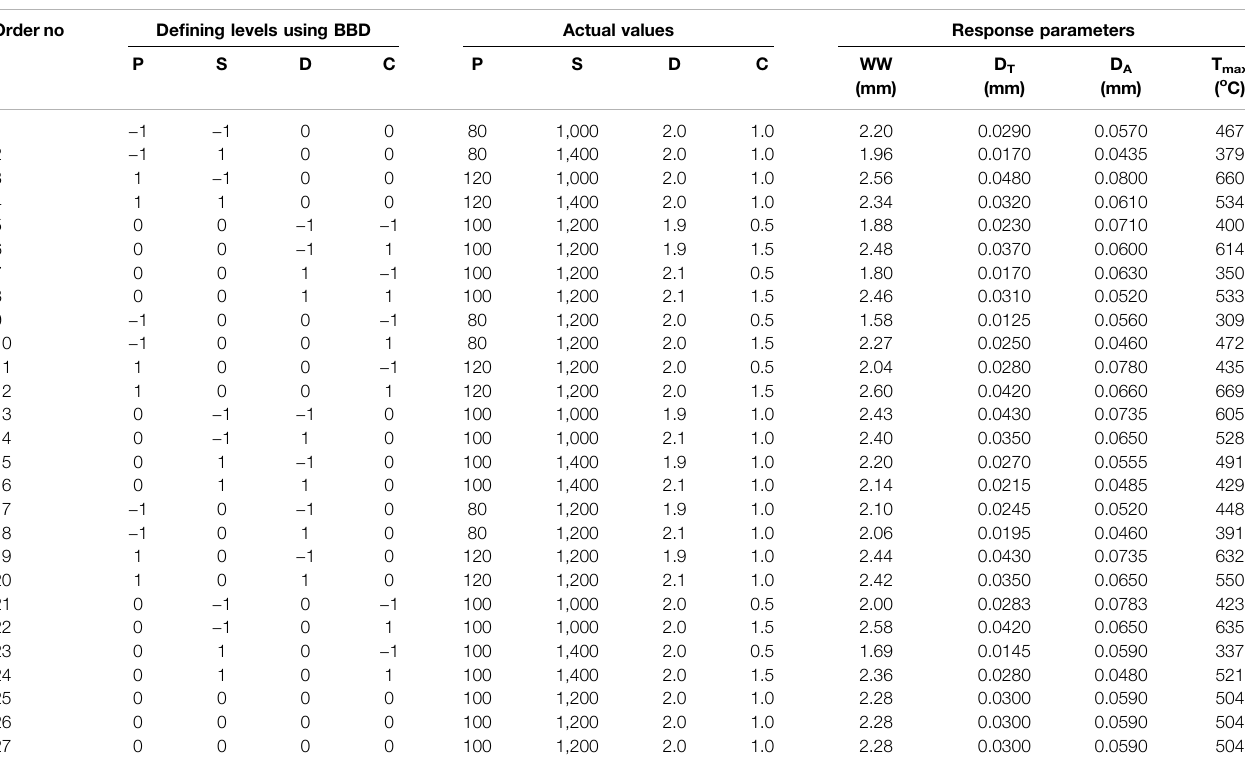
TABLE3| Box-Behnkenexperimentaldesignandresponsevaluesforweldwidth(WW),welddepthsintransmissivelayer(D T )andabsorptivelayer(D A ),andmaximumweld temperature (T max ). Order no De fi ning levels using BBD Actual